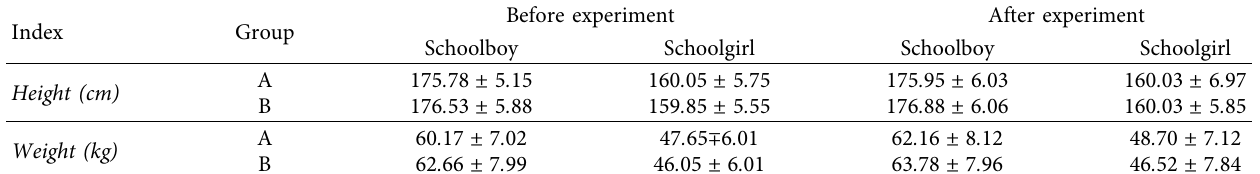
Table 4: Comparison of body shape between boys and girls before and after the experiment.